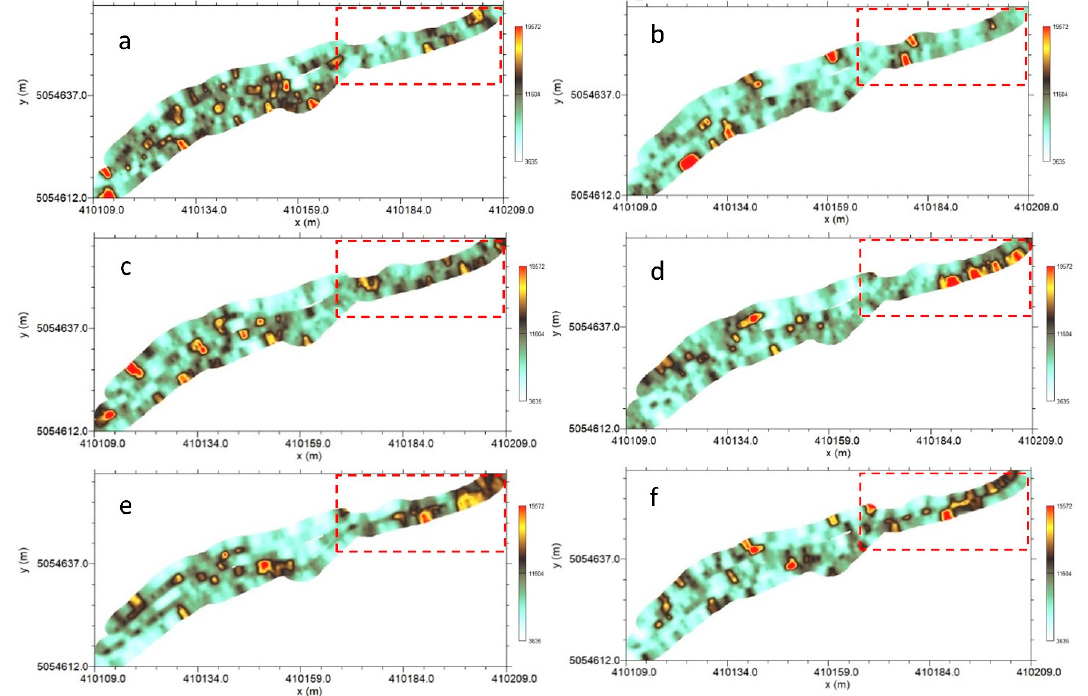
Figure 5. GPR sections taken at di ff erent depths: ( a ) Z = 1.0 m; ( b ) Z = 2.0 m; ( c ) Z = 3.0 m; ( d ) Z = 4.0 m; ( e ) Z = 5.0 m; and ( f ) Z = 6.0 m. The colour scale represents the ability of the medium to absorb/let the pulse pass through it.